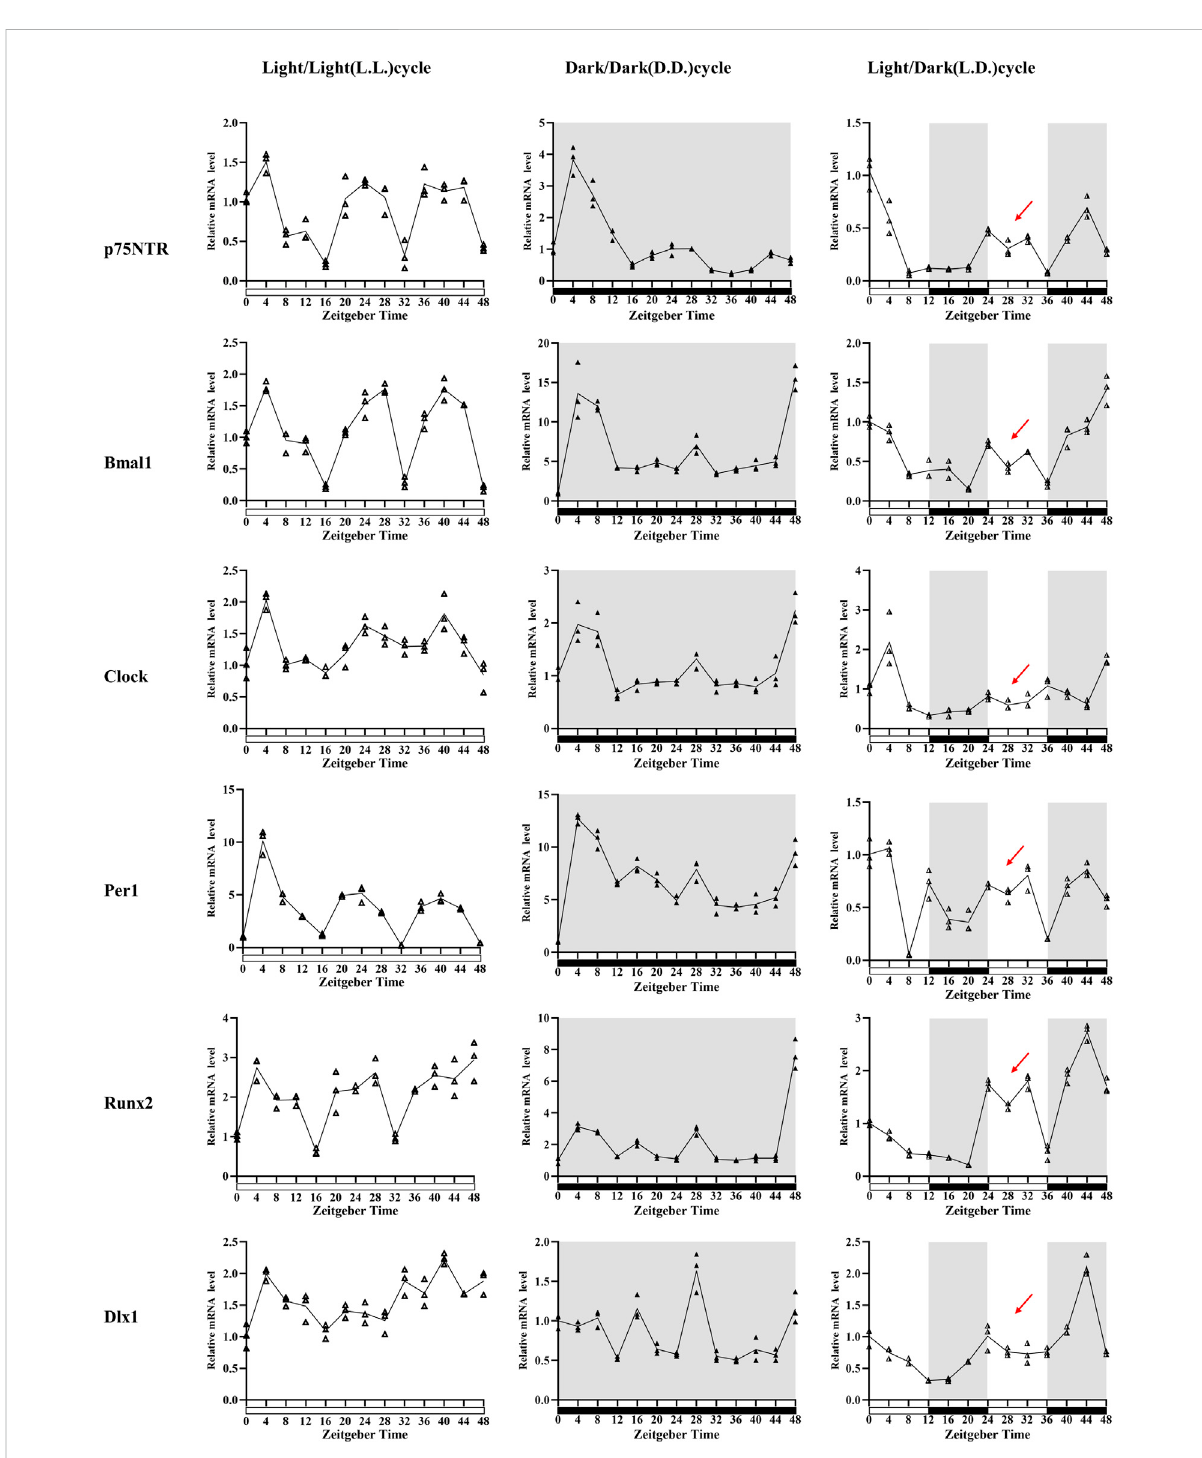
FIGURE 3 The in vitro observation of circadian rhythm dynamics in rat E18.5 d EMSCs. Quantitative RT-PCR analyses depicted that p75NTR mRNA expressionpatternsweresimilarinthreeconditions:higherataboutZT4,ZT24,andZT36-44andlowerataboutZT16,ZT32,andZT48.However,the patterns had highest amplitudes, and a supramaximal peak was detected at ZT4 in the D.D. condition. Of the three clock genes, Bmal1 and Clock showed a similar mRNA expression pattern to p75NTR in three conditions. Per1 was similar in the L.L. condition, but four, not three, peak times presentedintheL.D.andD.D.conditions.Themineralization-relatedfactors Runx2 alsoshowedasimilarmRNAexpressionpatternto p75NTR inL.L. and D.D. conditions, but four peak times were observed in the L.D. condition: ZT0, ZT24, ZT32, and ZT44. The odontogenesis-related factor Dlx1 showedirregularoscillatingexpressions:ZT4,ZT20,ZT32,andZT40intheL.L.condition;ZT8,ZT16,ZT28,ZT40,andZT40intheD.D.condition;and ZT0, ZT24, andZT44intheL.D. condition. Besides, thepeak atZT28 inall thesix detectedfactorsinD.D. condition, but itwas replaced by aV-shape (as indicated by the red arrows) in the L.D. condition when the cells were exposed to the second 12-h light stimulus. All experiments were repeated three times independently. Data are expressed as mean ± S.D. n = 13 per